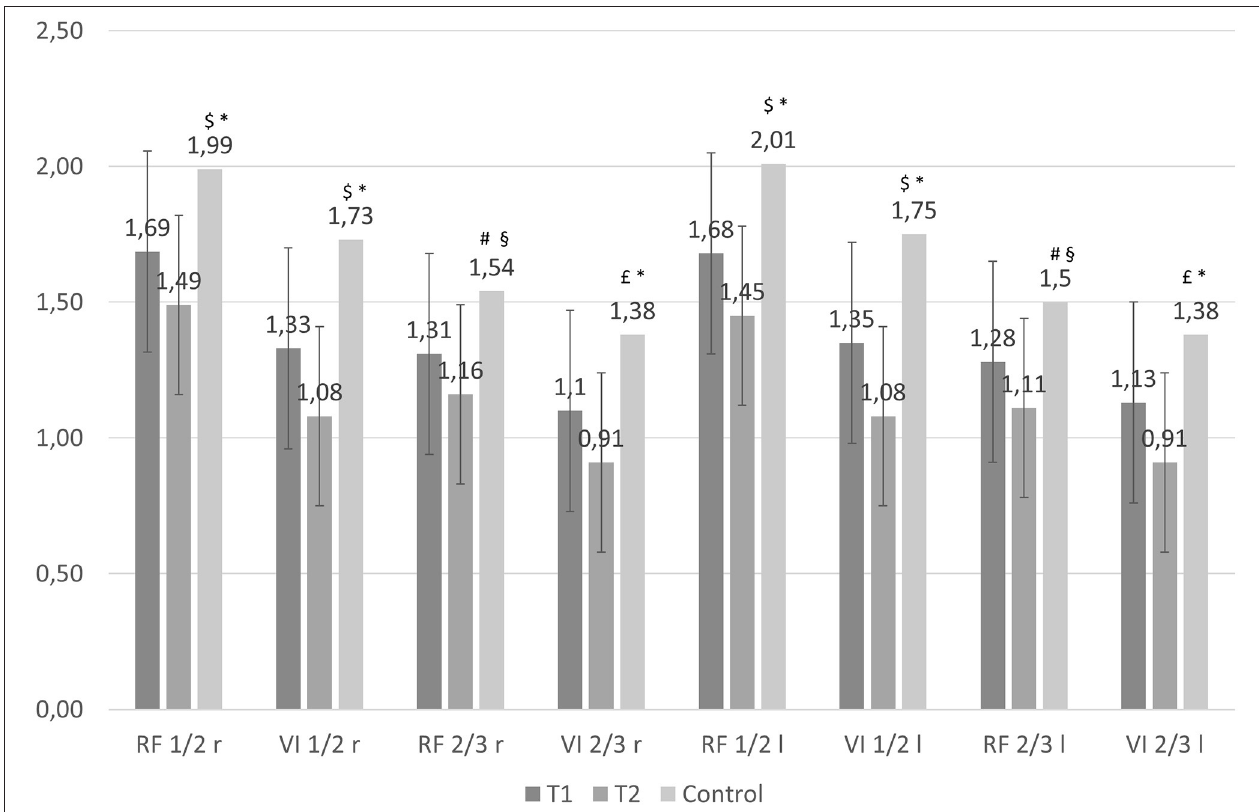
FIGURE 1 | Muscle thickness of patients with AKI (baseline, T1, and after 5 days, T2), and control group. The first 2 columns represent the mean and 95 percent confidence interval (vertical bar) of muscle thickness at each measurement site as estimated by the mixed effect model, at baseline (T1) and after 5 days (T2). The third column represents the control group. The average difference between baseline and 5 days was statistically significant at all measurement sites ( P < 0.001). When comparing the difference between patients and healthy subjects, muscle thickness was different between controls and baseline (T1) values of patients: $ P = 0.001, # P < 0.05, P < 0.01; P < 0.001 in comparison to muscle thickness of patients after 5 days (T2). After adjusting the analysis for age and sex using ANCOVA, no statistically significant difference was found between T1 values and controls; when comparing to T2 values, muscle thickness difference remained statistically significant for all sites: * P < 0.01, § P < 0.05.